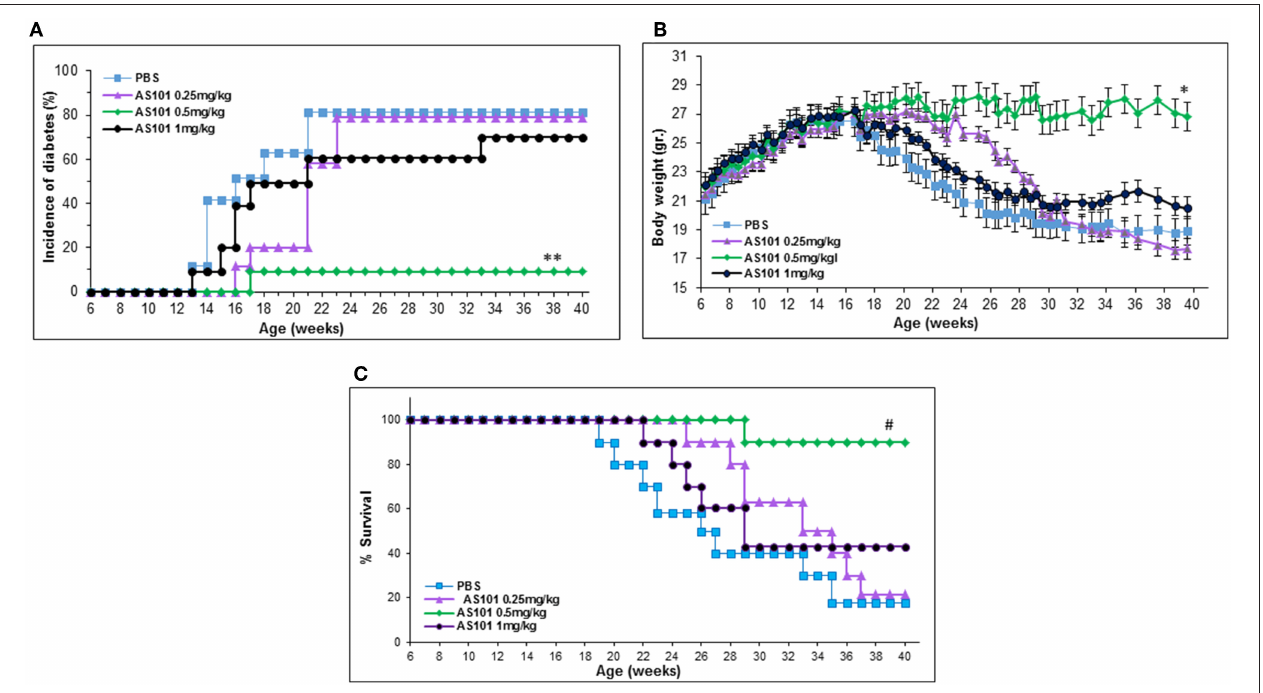
FIGURE 5 | Treatment with AS101 starting at 5–6 weeks of age prevents the development of T1D in NOD mice. AS101 was administered i.p. every other day at different doses to female NOD mice, starting at 5–6 weeks of age, until 40 weeks. The incidence of diabetes (glucose levels at least 200 mg/dL (A) , body weight (B) , and percent survival (C) were monitored. n = 10 animals/group. ** p < 0.05 decrease vs. PBS; * p < 0.05 increase vs. PBS; # p < 0.05 increase vs.